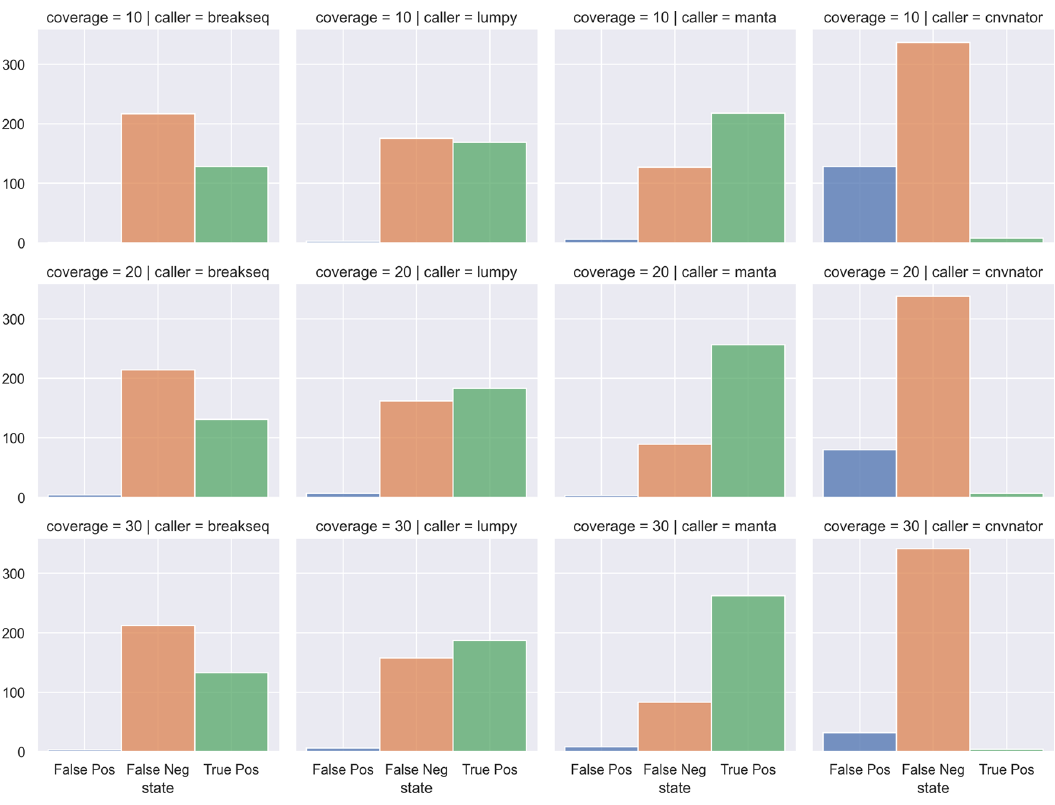
Figure18.AcomparisonofsimulatedDELsacrossSVcallersandsequencingcoverages. CountofFalsePositives, FalseNegatives,andTruePositivesfromfourSVcallers(columns)againstchromosome2deletionsthroughmultiple simulated coverages (rows). SV callers: breakseq, lumpy, manta, cnvnator. Coverages: 10x, 20x, 30x.